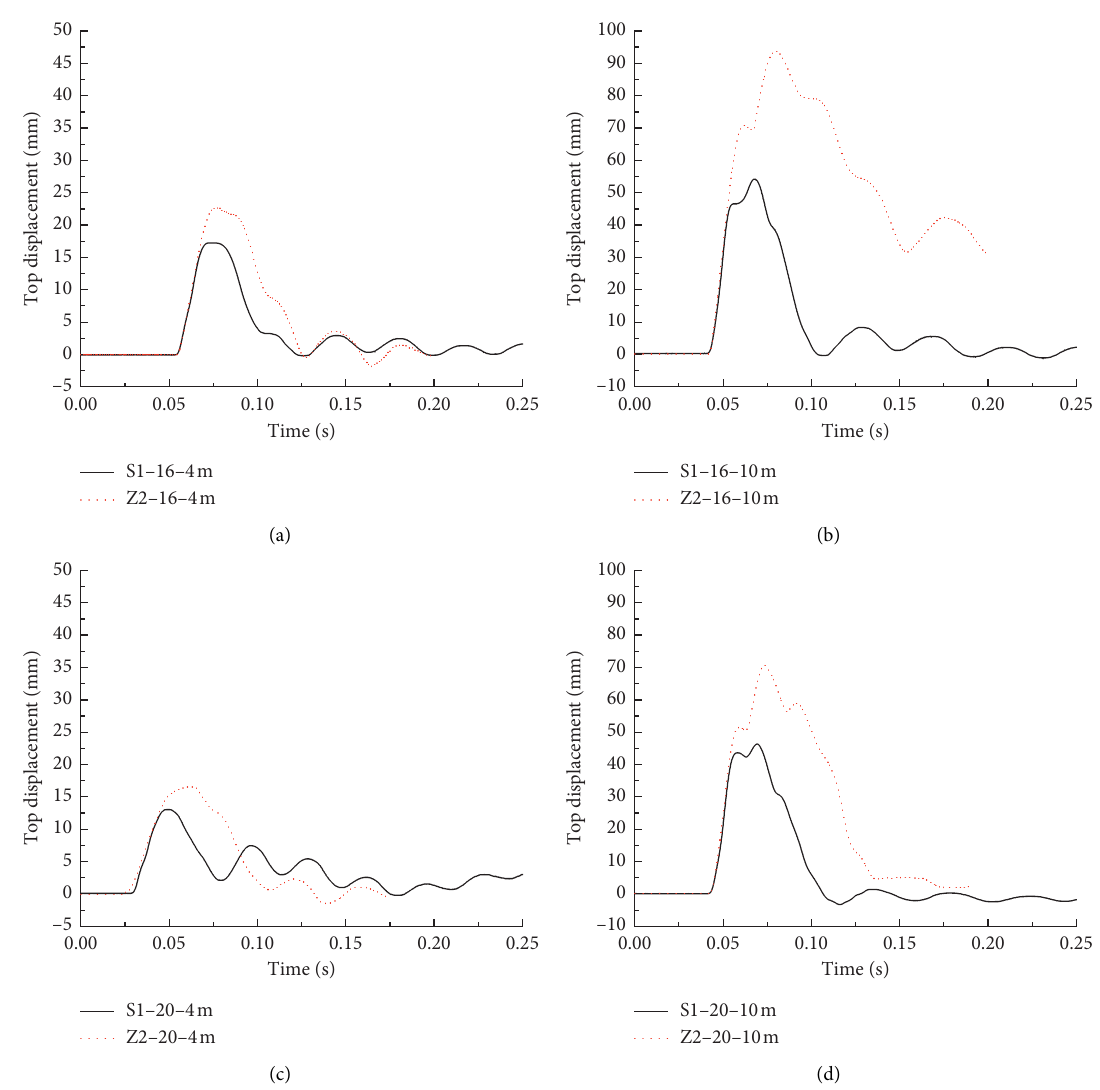
Figure 13: Time history curve of the top displacements of the specimens with the drop hammer lifted to 4m and 10m, respectively. In the figure, diameter 16 has a 50mm closed-cell aluminum foam application and diameter 20 has a 100mm closed-cell aluminum foam